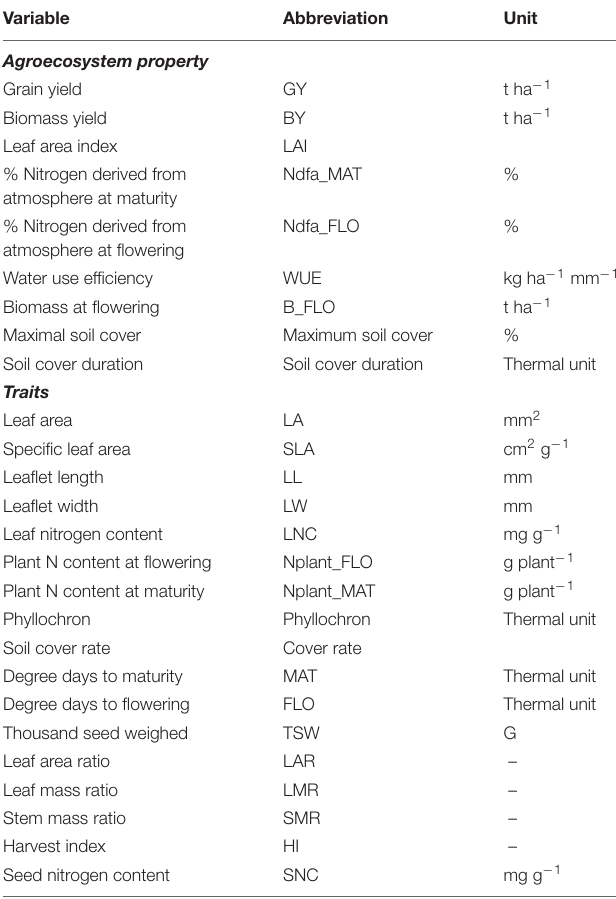
TABLE 2 | List of agroecosystem properties and traits measured in the experiment with their respective abbreviation and unit.